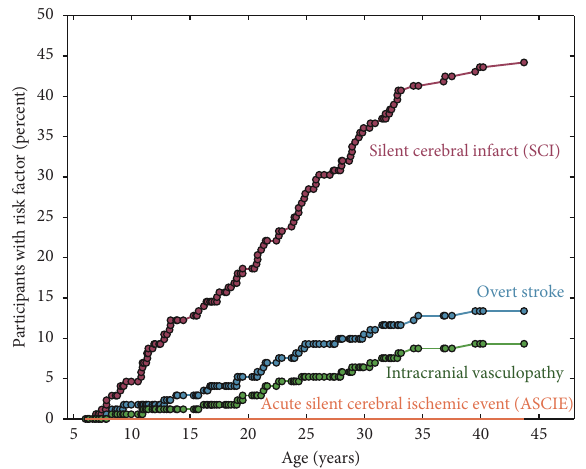
Figure 2: Cumulative incidence of radiological risk factors with age over the 172 participants. Note that no participants exhibited evidence of acute silent cerebral ischemic events on diffusion- weighted imaging